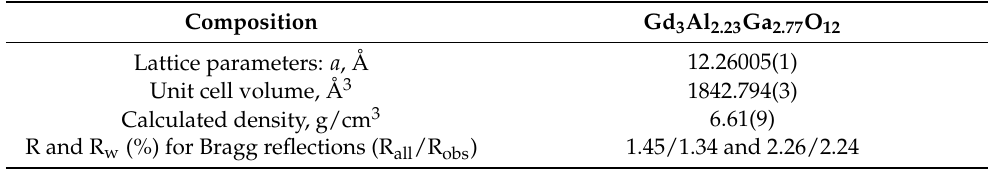
Table 1. Crystallographic data and refinement results for the Gd 3 Al 2.23 Ga 2.77 O 12 :Ce structure (SG Ia 3 d , Z =